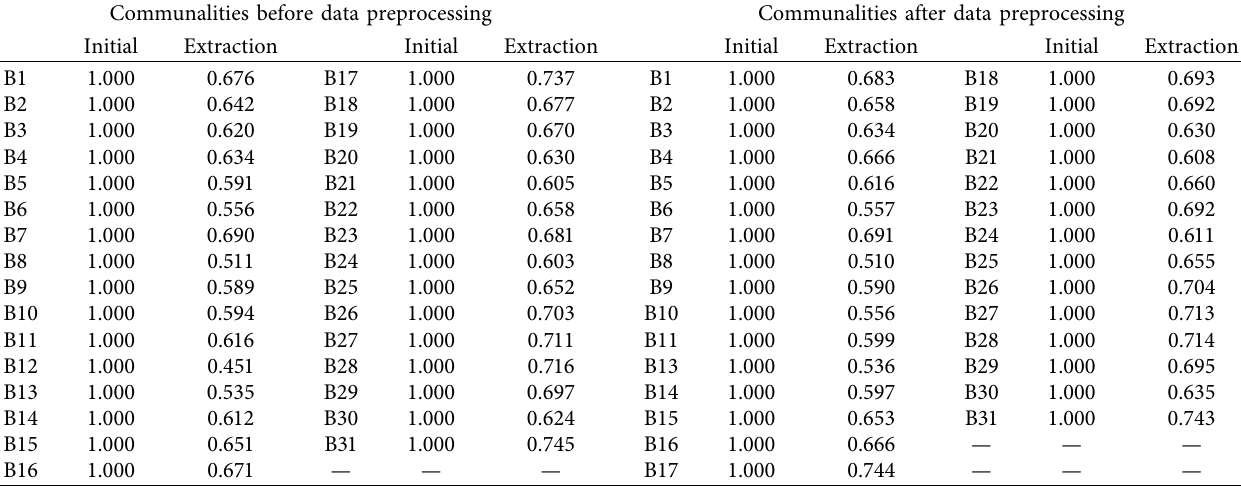
Table 7: Commonality before and after data preprocessing. Communalities before data preprocessing Communalities after data